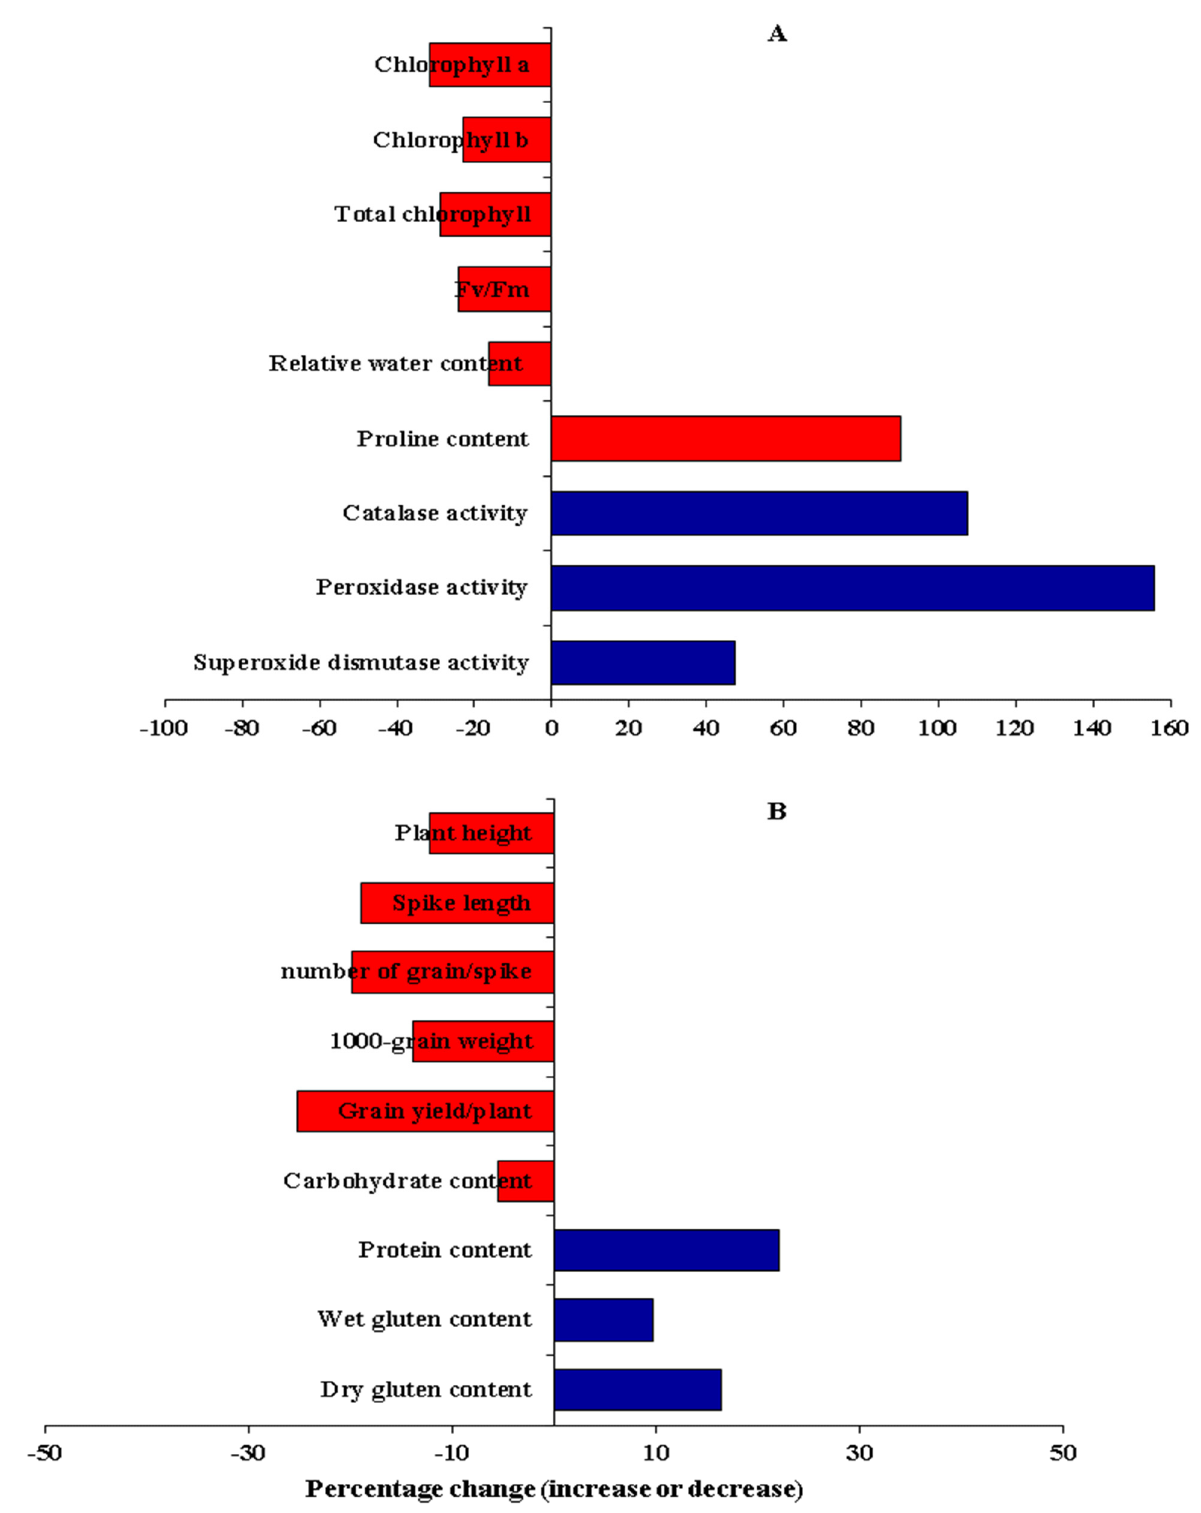
Figure 3. Percentage change (increase or decrease) in physiological and biochemical traits ( A ) and agronomic and grain quality traits ( B ) exposed to drought stress compared with well-watered wheat plants.